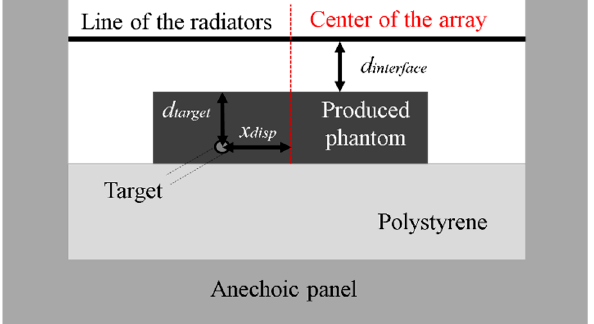
Figure 2. Sketch of the measurement scenario with the phantom, where d target is the depth of the inclusion within the phantom, d interface is the distance of the phantom from the array, and x disp is the lateral displacement of the target with respect to the center of the array.